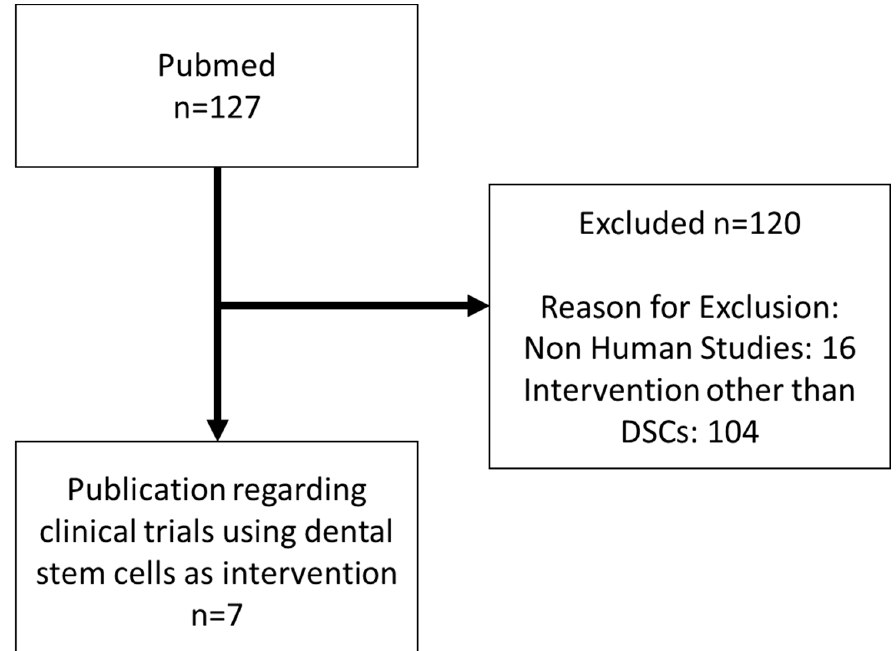
Figure 7. Systematic review flow chart of the systemic literature review and general characteristics of the included publications. In total, 127 publications were identified, of which 16 publications were excluded since they reported no clinical use or were not clinical trials or clinical studies, and 104 reports on clinical studies were excluded, since the clinical trials did not investigate dental stem cells or use dental stem cells as an intervention. A total number of seven publications reported the clinical use of dentals stem cells or used dental stem cells as an intervention.